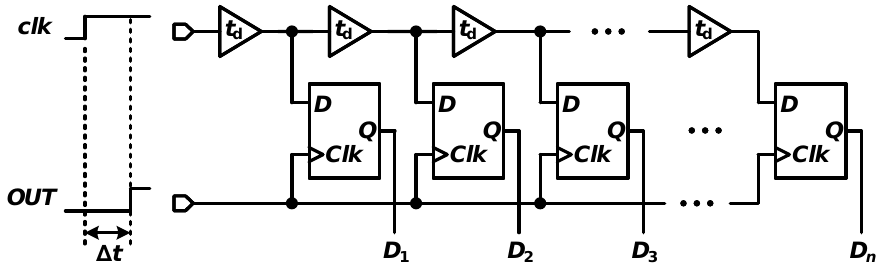
Figure 5. Schematics of the Time-to-Digital Converter.